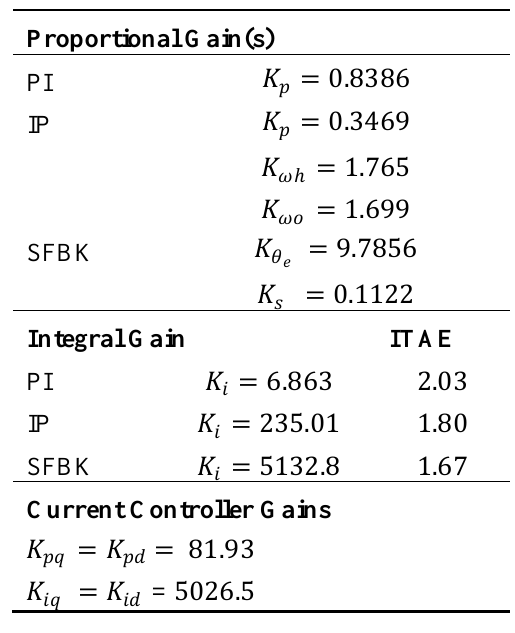
Table 2. Gains of the implemented